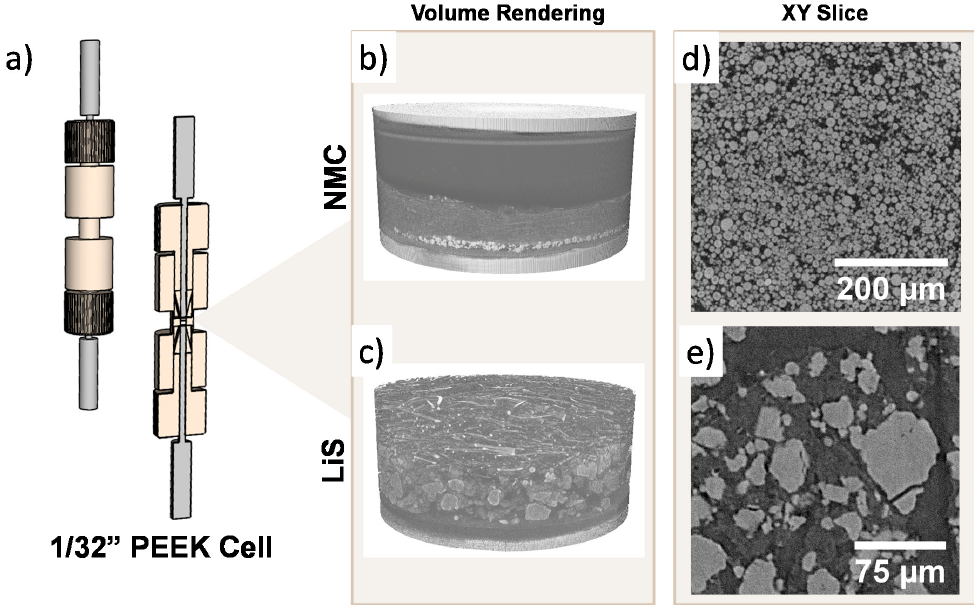
Figure 7. ( a ) Rendering of the 1/32’ PEEK cell. ( b ) Volume rendering of NMC acquired at 20× magnification and ( c ) Li-S electrodes acquired at 40× magnification and the ( d , e ) their respective virtual slices.